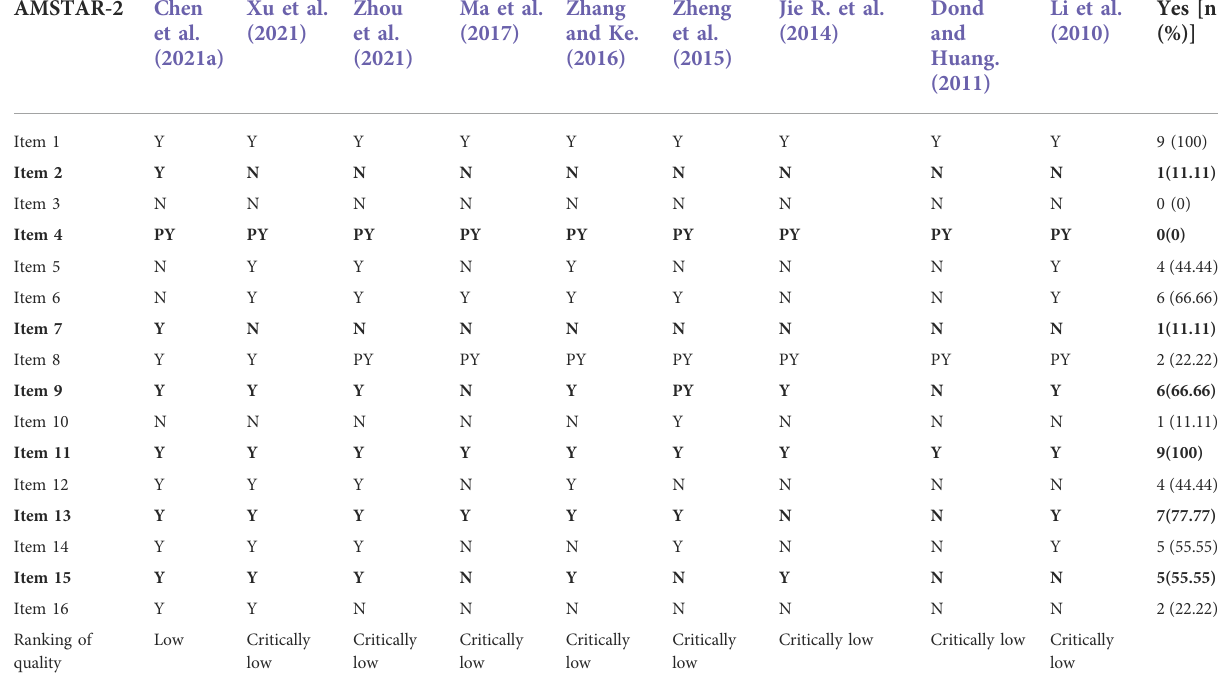
TABLE 2 Methodological quality assessment of SRs by